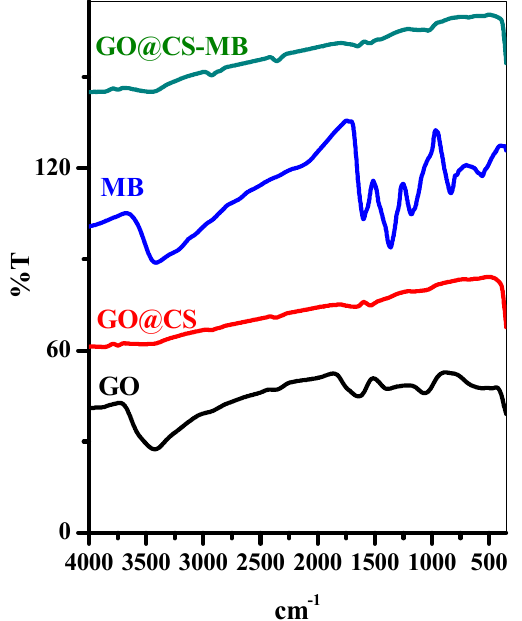
Figure 4. FTIR patterns of GO, GO@CS beads, MB and GO@CS beads-MB complex.